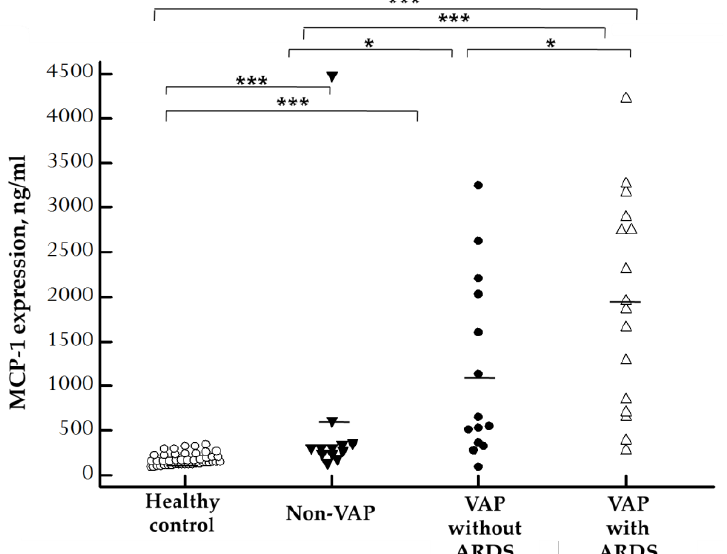
Figure 4. Scatter plots of plasma MCP-1 levels in 45 healthy control, 12 non-VAP subjects, and 30 patients with VAP who were divided into patients without ARDS and patients with ARDS on the basis of ELISA results. MCP-1 concentration was significantly higher in VAP-with-ARDS patients than in patients without ARDS ( p = 0.0417), healthy controls ( p < 0.0001), and non-VAP subjects ( p = 0.0004). Moreover, there was a significant difference between non-VAP subjects and healthy controls ( p = 0.0007). Plasma MCP-1 levels were significantly increased in VAP-without-ARDS subjects compared with non-VAP subjects ( p = 0.0156) and healthy controls ( p < 0.0001). Each dot represents a single patient. The solid lines mark the mean values. The mean concentration of plasma MCP-1 was determined by Kruskal – Wallis tests for multiple comparisons and then examined by the Mann – Whitney U test between groups. * p < 0.05, *** p < 0.001 by statistical analysis.